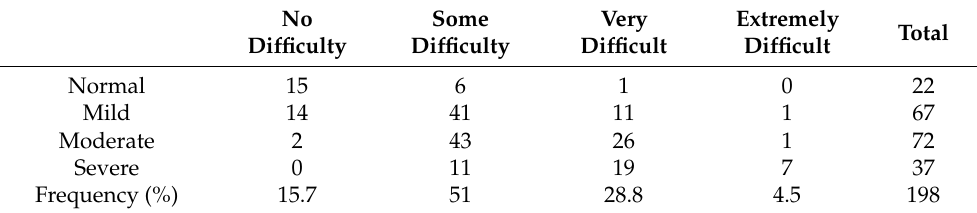
Table 4. Difficulty to work, to do tasks at home or to be in contact with